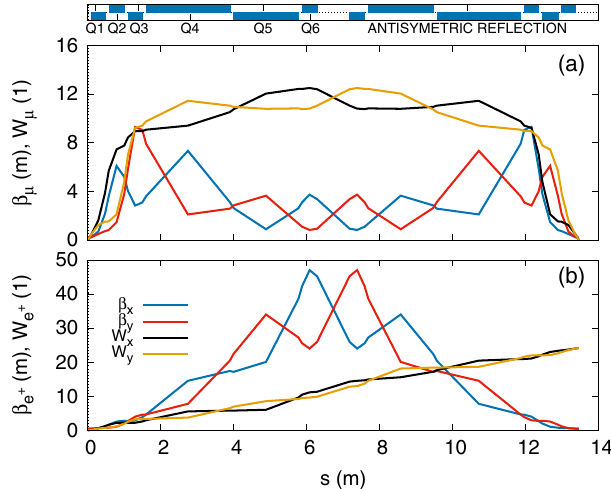
FIG. 3. (a) Twiss β x , β y and chromatic W x , W y functions along the transport line at the nominal energy for the muon beam and (b) twice the nominal energy for the positron beam. Top: we show the quadrupoles Q1 to Q6 location and the antisym- metric reflection of the quadrupole configuration to achieve the apochromaticity at the muon energy, W x;y ¼ 0 at s ¼ 0 and s ¼ 13 . 455 m, where the targets are located.